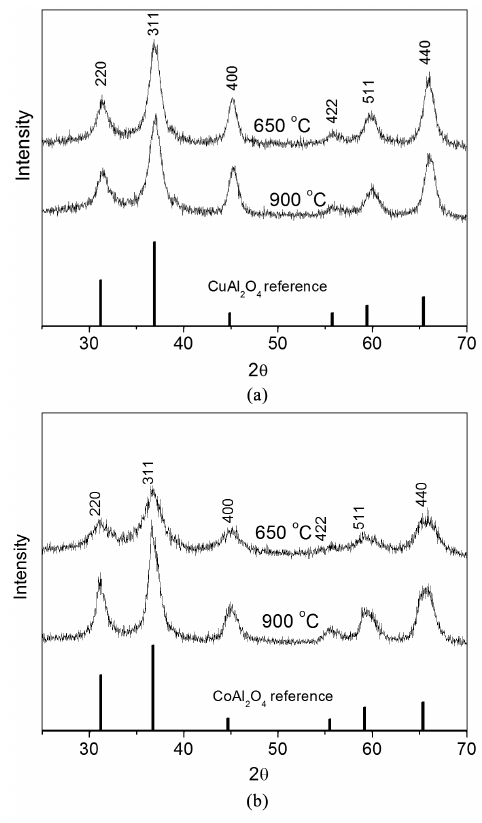
Figure 1. XRD patterns of (a) copper and (b) cobalt aluminates prepared at 650 and 900 °C. Inset at figure (a): CuAl according to JCPDS card no. 33-0448, and inset at figure (b): CoAl reference according to JCPDS card no. 44-0160.